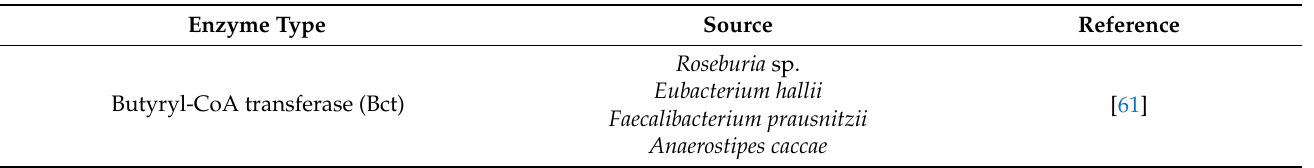
Table 2. Some of the CoA-transferases capable of production of lactyl-CoA. Enzyme